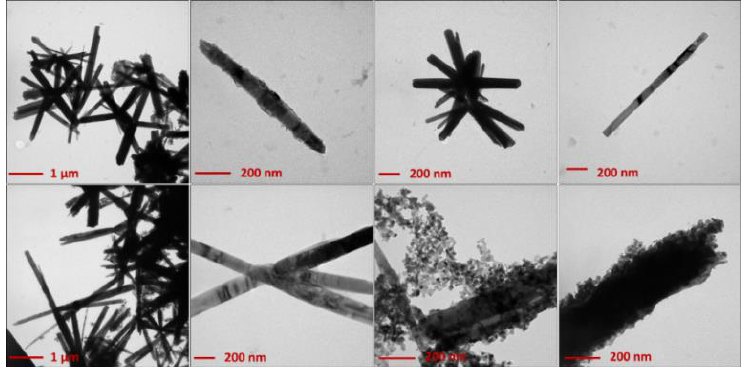
Figure 1. Transmission electron microscopy (TEM) images of electrosynthesized ZnO-based materials in the presence of benzyl-dimetylammonium chloride (BAC). Upper panels: ZnO dried at 120 °C overnight; lower panels: ZnO calcined at 450 °C for 1 h.